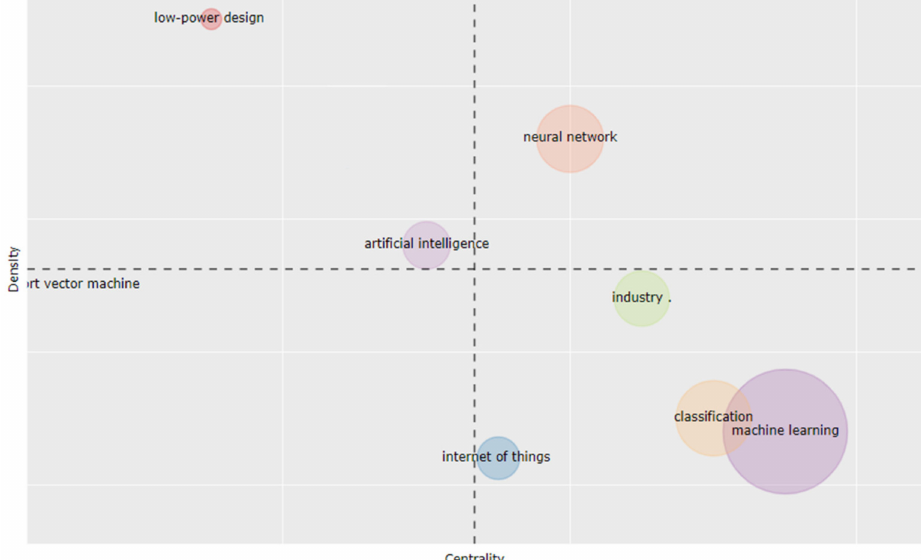
Figure 9. Thematic map, time slice 2.